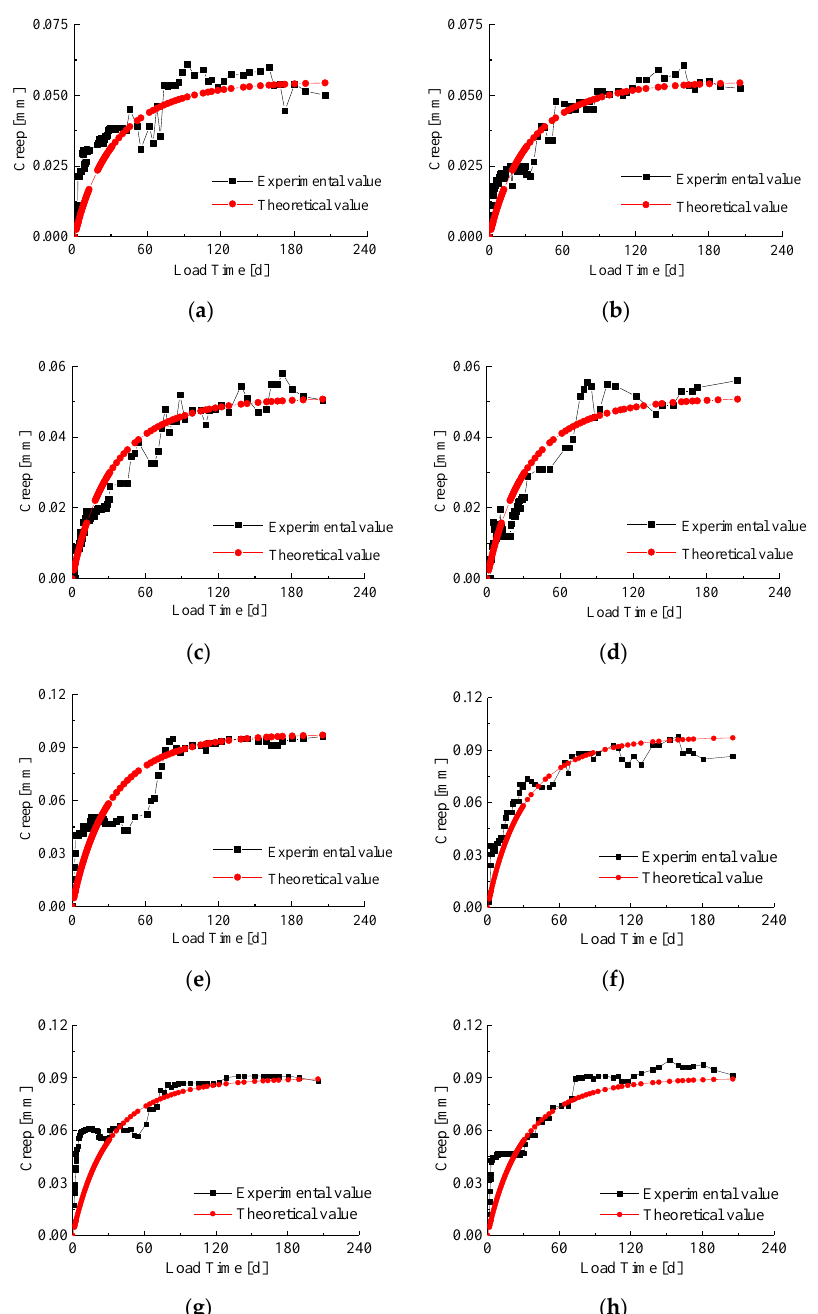
Figure 10. Comparison between theoretical value and experimental value. ( a ) 1-b; ( b ) 2-b; ( c ) 3-b; ( d ) 4-b; ( e ) 1-c; ( f ) 2-c; ( g ) 3-c; ( h ) 4-c.